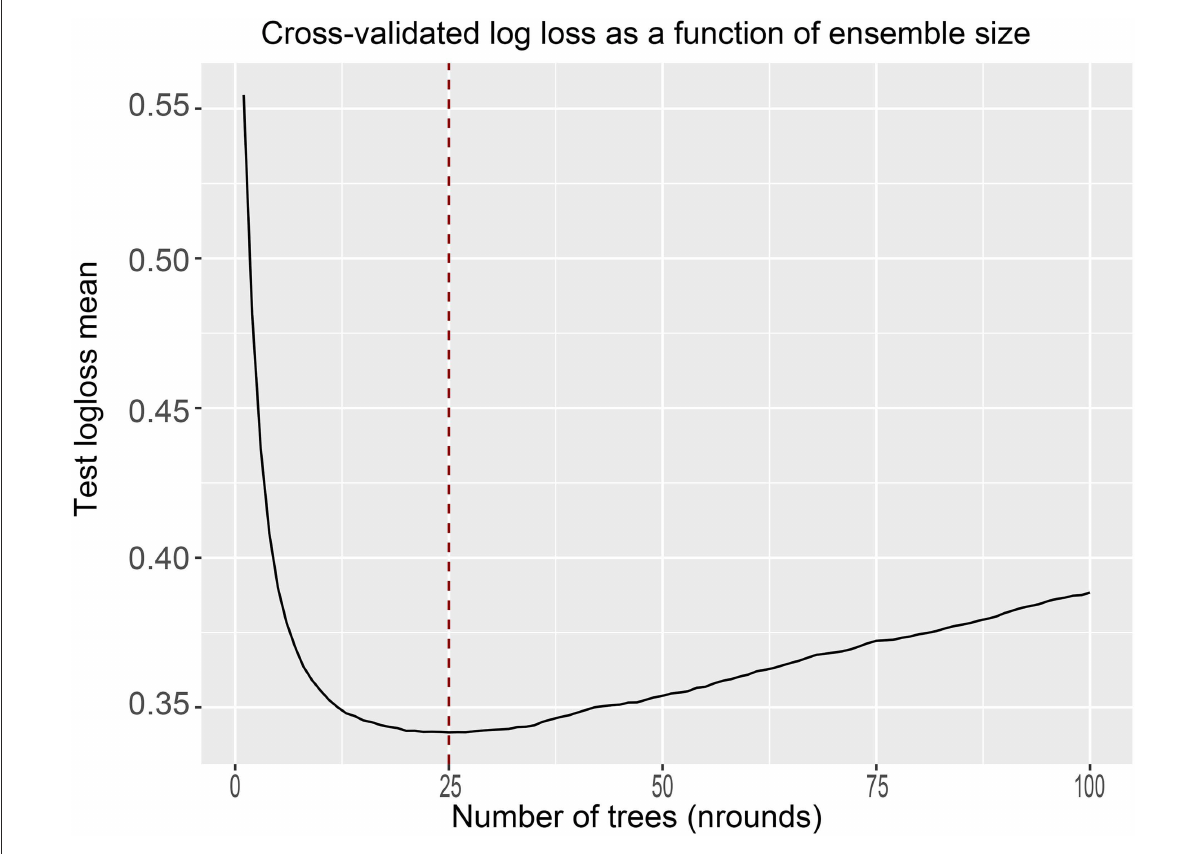
FIGURE5 10-fold cross-validation in the train set to determine the optimal number of